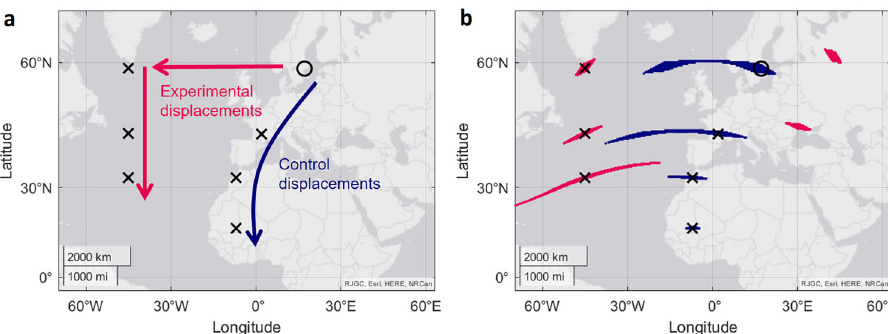
Fig. 3 Bi-coordinate virtual magnetic displacements in ref. 16 . a Experimental design of the study. The test site near where the birds were captured is marked with a black circle. The suggested virtual magnetic displacement locations are marked with a black cross. b All locations with the same values of total intensity and inclination as those of the virtual magnetic displacements (±200 nT and 0.5° inclination). Blue areas are the possible locations for the control displacement, and pink areas for the experimental displacements.